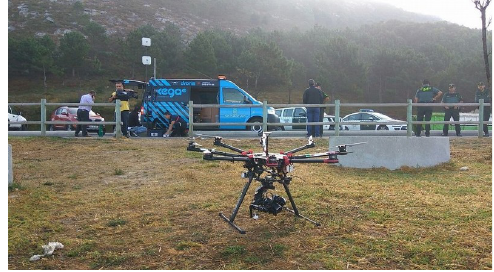
Figure 6. Image of AtlantikSolar